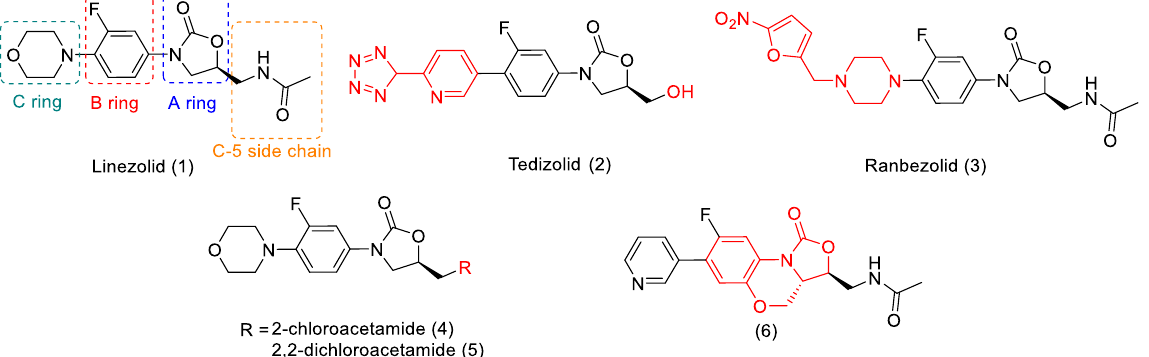
Figure 2. Oxazolidinones on the market are linezolid (1) and tedizolid (2), with the A ring, B ring, C ring and C-5 side chain indicated on linezolid. Examples of modifications to the linezolid scaffold include morpholine modification (3), C-5 side-chain modifications (4) and (5), and oxazolidinone modification (6) from the oxazolidinone dataset. The image was created using ChemDraw.